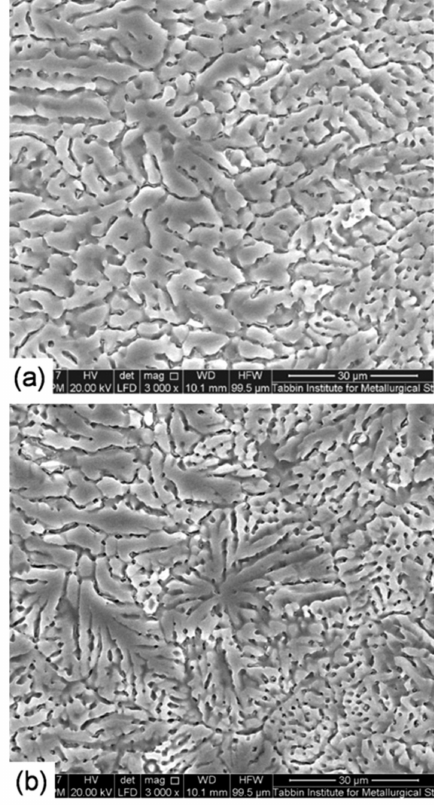
Figure 9. SEM photographs of WM of the high ( a ) and low ( b ) heat input laser-welded joints.